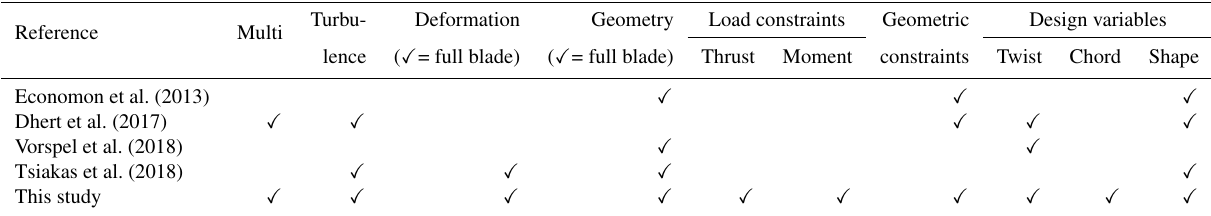
Table 3. Overview of aerodynamic optimization works of wind turbine rotors using the adjoint method. Turbu- Deformation Geometry Load constraints Geometric Design variables Reference Multi